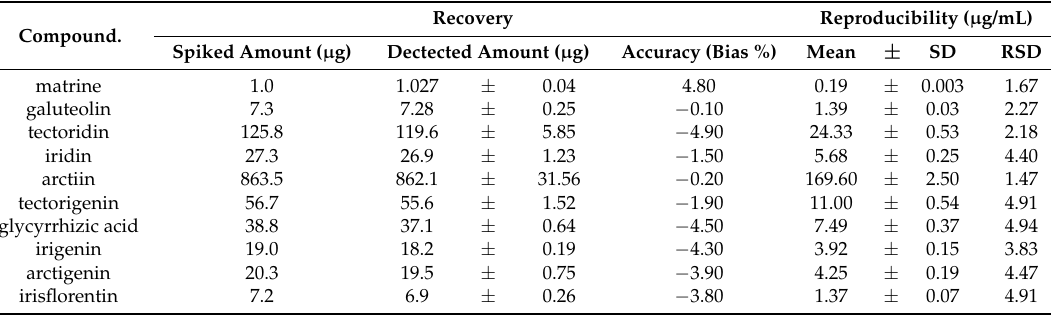
Table 4. Recovery and repeatability of these ten compounds ( n =